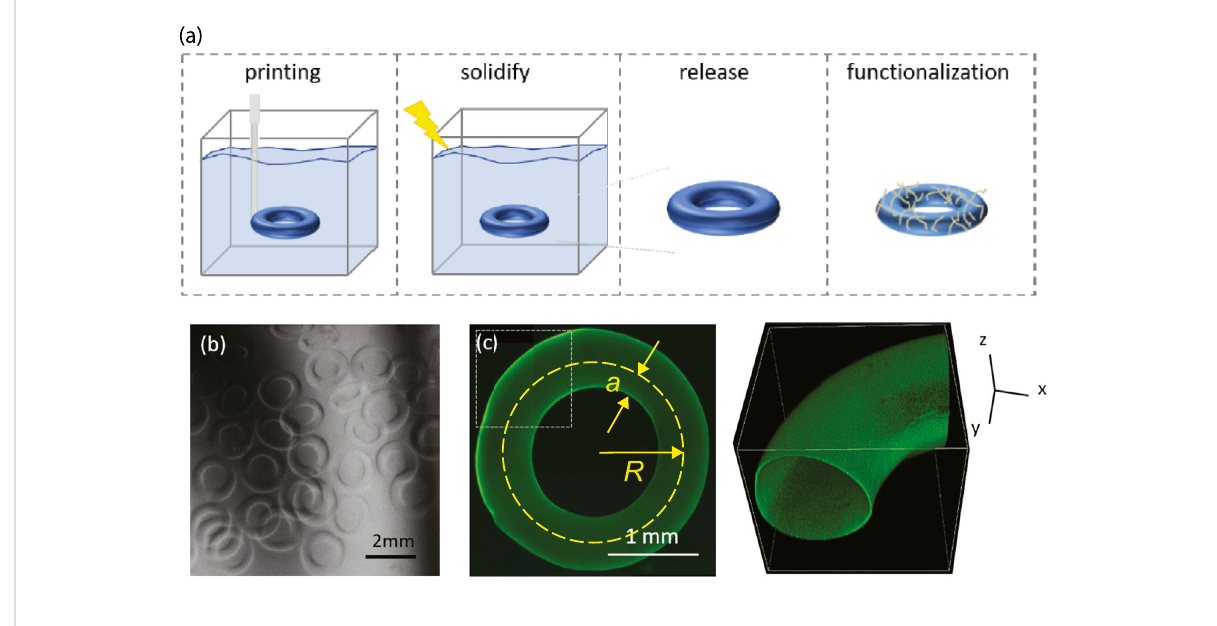
FIGURE 1 (A) Schematic of a hydrogel tori made by printing into a silicone support bath that is subsequently surface-activated via protein grafting. (B) ImageofPAtoroidalhydrogelsinwaterafterbeingreleasedfromthesupportbath.Thedarkregionsareshadowsofobjectsplacedinthelightpathto enhancecontrastofthehydrogel edgeviewedwithbright fi eldimaging. (C) Confocalimagesofcollagen-coatedPAtoroidalhydrogelsviewedin2D (left) via maximumintensityprojectionontothexy-planeandin3D(right)forthesectionofthehydrogelhighlightedwithasquareboxinthe2D image. Geometric parameters of a torus: ring radius R and tube radius a